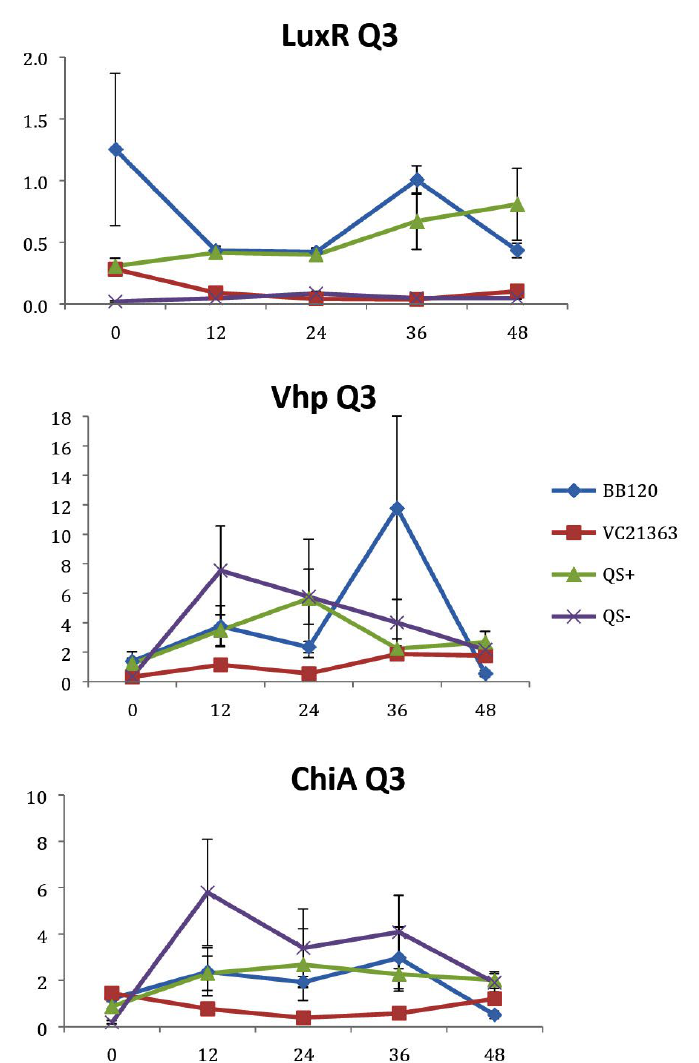
Fig. 3. Relative gene expression levels of luxR, vhp and chiA over a 48h period in treatment Skeletonema 2x10 4 cells per ml and Vibrio =10 7 cells per ml. Y-axis= Relative expression to RpoA, X-axis= Time elapsed (hr). Error bars represent standard error of